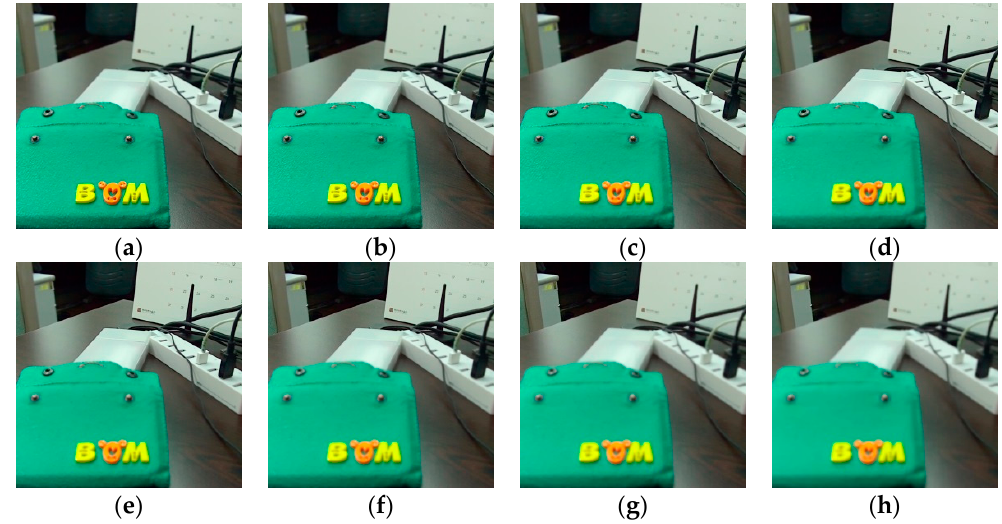
Figure 2. Input images: ( a – h ) of different focal lengths.